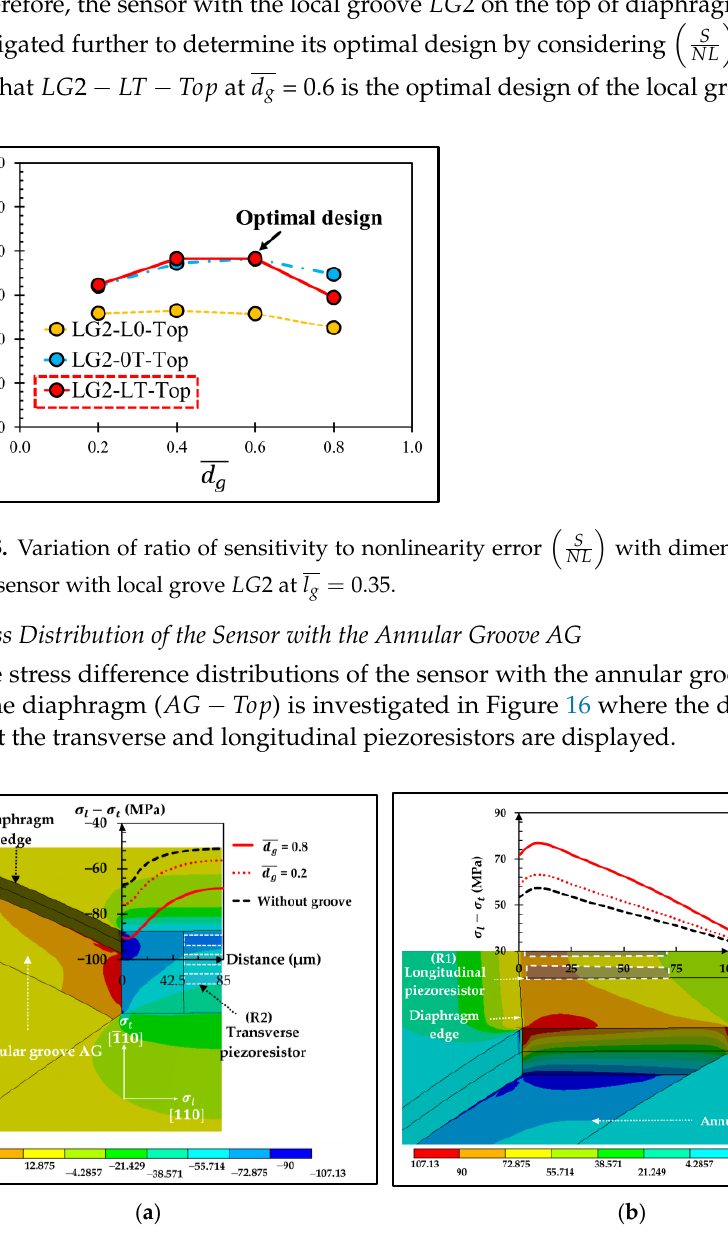
Figure 14. Comparisons of ( a ) sensitivity and ( b ) nonlinearity error between sensors with local groove 𝐿𝐺2 and 𝑙 𝑔 ̅ = 0.35 on top and at bottom of diaphragm.